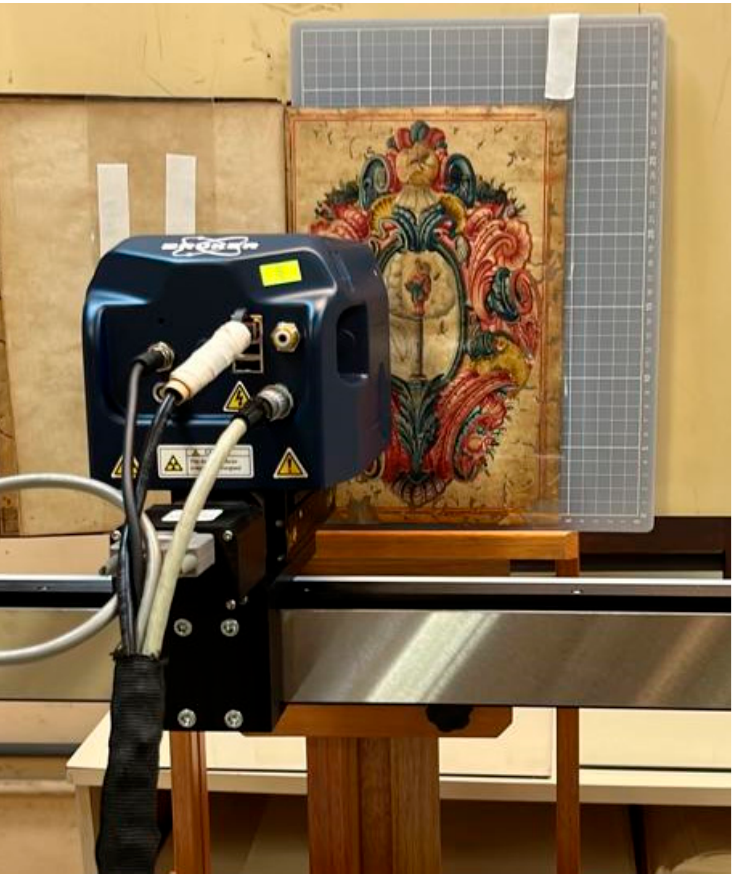
Figure 1. The module which contains the X-ray tube and detector of the MA-XRF system used in the analyses.